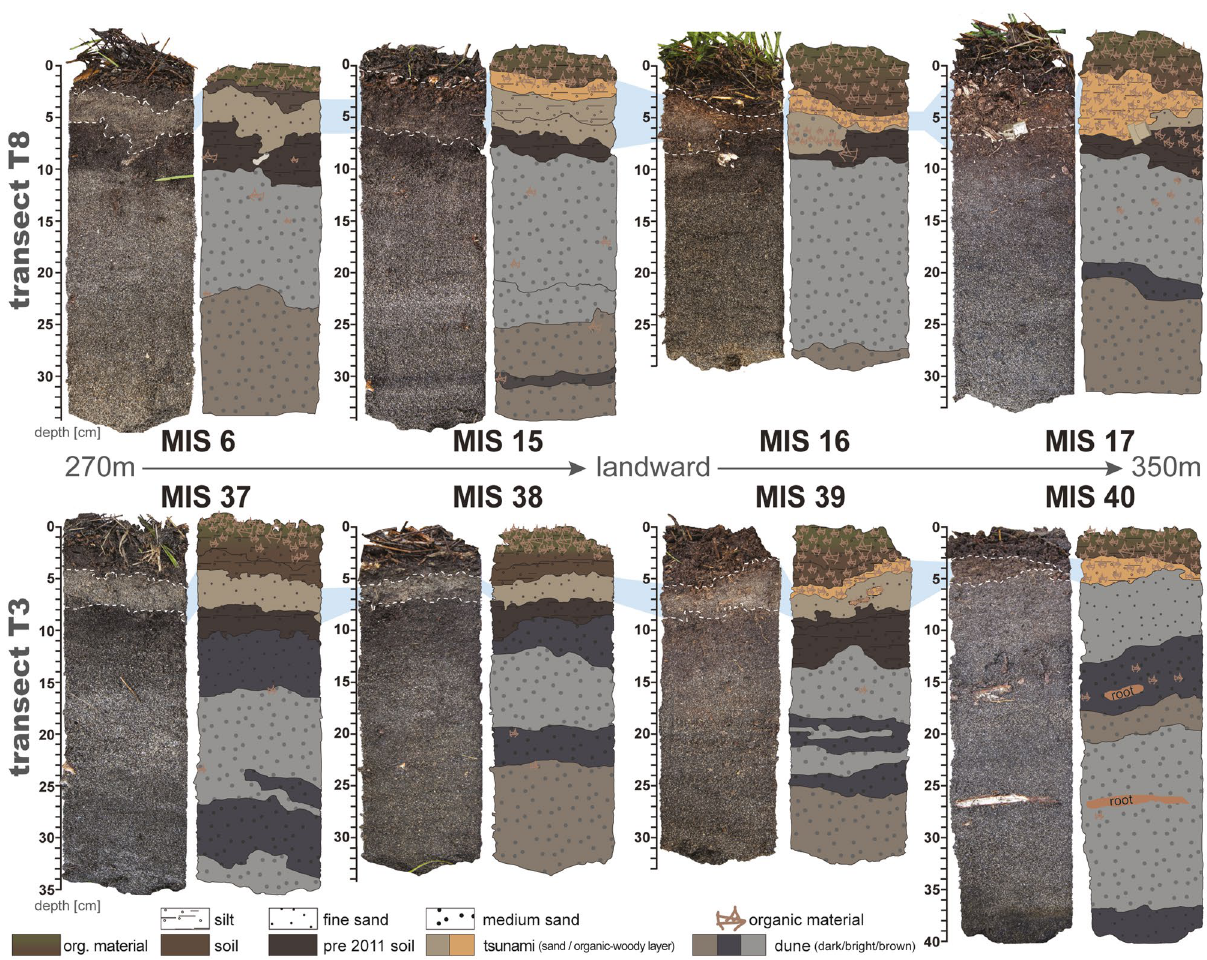
Figure 3. Photographs and visual representation of all stratigraphic profiles from transect T8 (top) and T3 (bottom). Profiles show thinning inland (left to right) of the 2011 tsunami sand deposits as well as a change in composition (to organic material). The tsunami deposits are marked by a blue band in the background, while upper and lower contacts of the tsunami deposits are indicated by dashed white lines. Shown data has been plotted using Microsoft Excel 365 (https:// office. micro soft. com/ excel) and is illustrated using Adobe Illustrator (Creative Cloud version 2020, https:// adobe. com/ produ cts/ illus